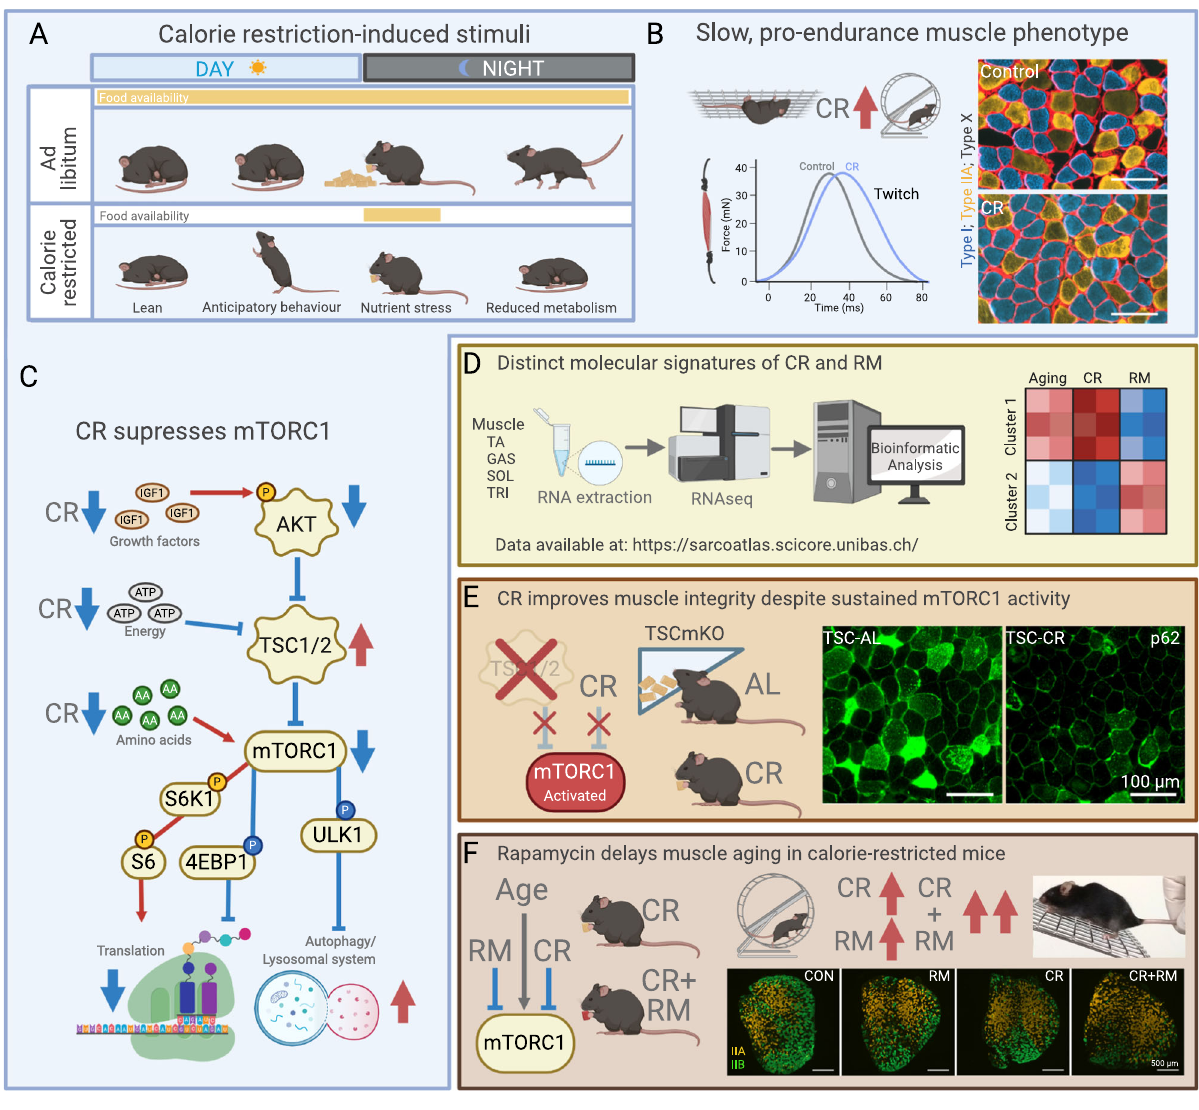
Fig. 8 Is rapamycin a calorie restriction mimetic? A Calorie restriction (CR) induces broad changes in activity (e.g., anticipatory behavior), metabolism (e.g., reduced metabolic rate), nutrition (e.g., nutrient stress and temporally compressed food intake) and body composition (e.g., reduced body mass and lean phenotype). B Long-term CR promotes a slow, pro-endurance muscle phenotype including improved endurance performance, slower contraction speeds and a fast-to-slow fi ber type shift, particularly in the depicted soleus muscle. C CR suppresses mTORC1 activity by lowering the availability of its positive regulators, including growth factors, energy, and amino acids, leading to reduced translation and increased autophagy. D Despite both RM and CR suppressing mTORC1 activity, long-term treatments exert distinct and often opposing molecular signatures in aging skeletal muscle. E CR improves muscle quality in TSCmKO mice, which display sustained, nutrient-insensitive mTORC1 activity and a premature sarcopenic phenotype, indicating that muscle mTORC1 suppression is not required for CR-induced bene fi ts. F While CR and RM both improve whole-body muscle function and promote a fast-to-slow fi ber type switch, the effects are frequently additive in calorie-restricted mice treated with RM. Together, these data demonstrate that RM is not a CR mimetic, but could rather be an adjunct therapy for CR-like interventions. Figure created with BSA overnight at 4 °C. The next day, slides were washed 3× 10min in PBS and incubated in secondary antibody solution containing DaGP Cy3 (706-165-148; Jackson; 1:500) and GaRt 488 (112-545-003, Jackson; 1:500) for 1.5h at RT. Afterwards, sections were washed 2× 10 min in PBS and mounted with Vectashield